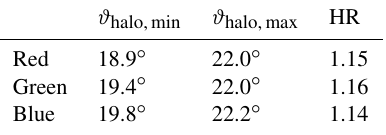
Table 2. The 22 ◦ halo features for the example of 12 May 2014 13:52UTC (as in Fig. 5). The relative zenith angle (which corre- sponds to the scattering angle) is listed for the minimum ϑ halo,min and maximum ϑ halo,max brightness of the 22 ◦ halo together with the brightness contrast, i.e., the halo ratio (HR) for the red, green and blue image channel. ϑ halo,min ϑ halo,max HR Red 18.9 ◦ 22.0 ◦ 1.15 Green 19.4 ◦ 22.0 ◦ 1.16 Blue 19.8 ◦ 22.2 ◦ 1.14